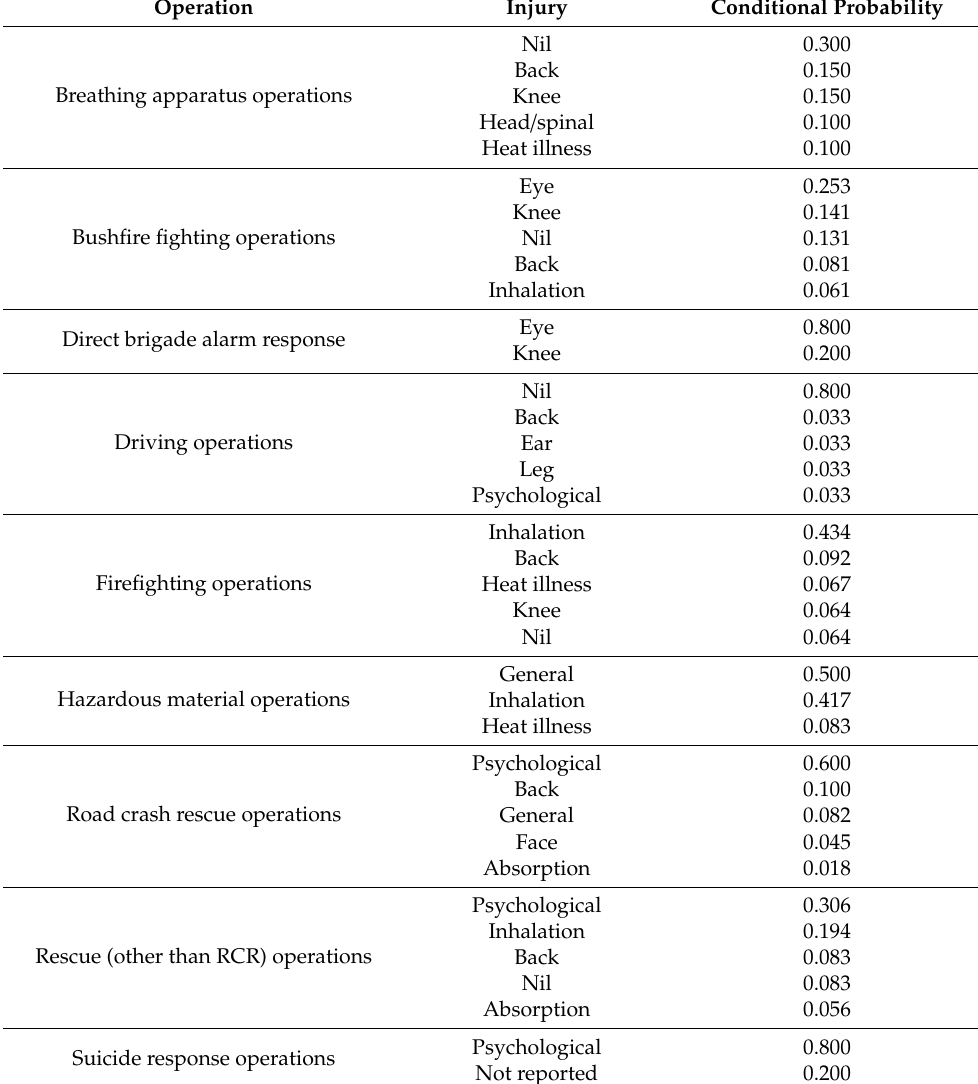
Table 4. Conditional probability of specific injury during incident